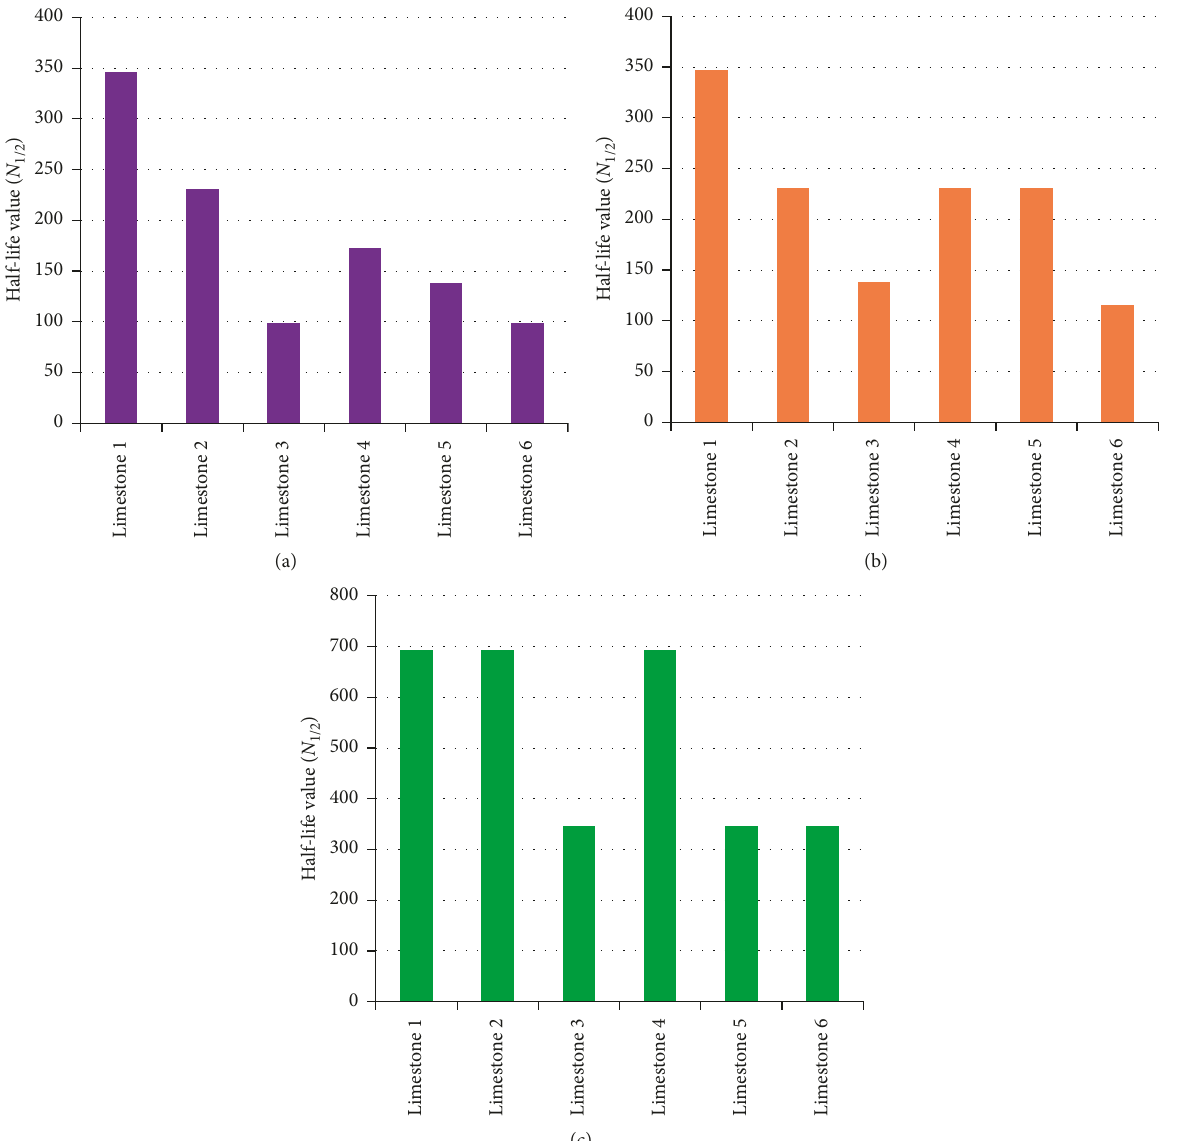
Figure 6: The half-life values ( N 1/2 ) of samples: (a) unconfined compressive strength; (b) point load strength; (c) Schmidt hammer